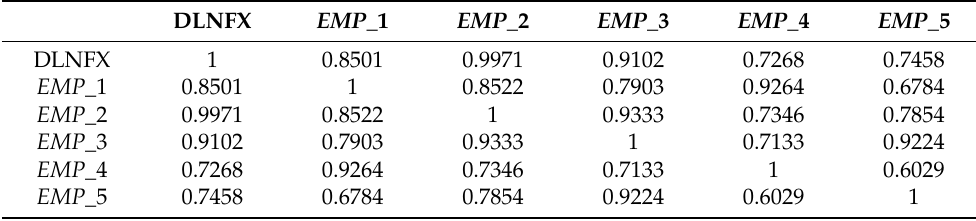
Table A1. Correlation results for South